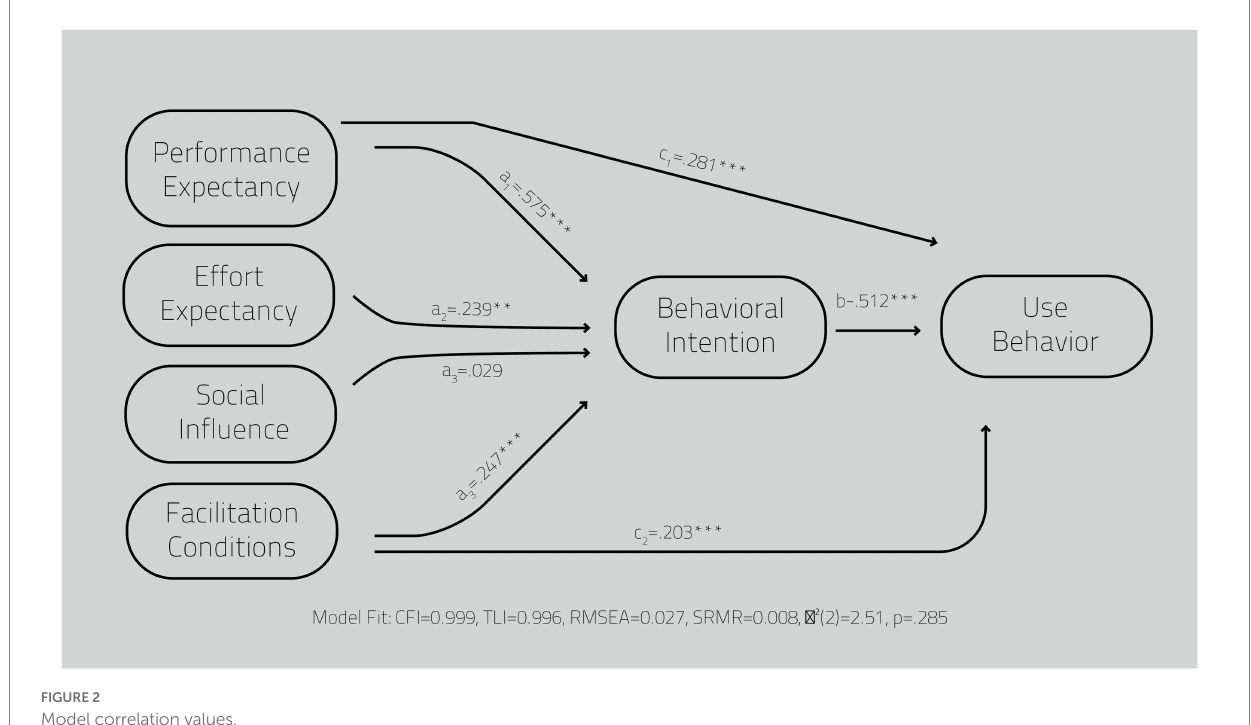
FIGURE 2 Model correlation